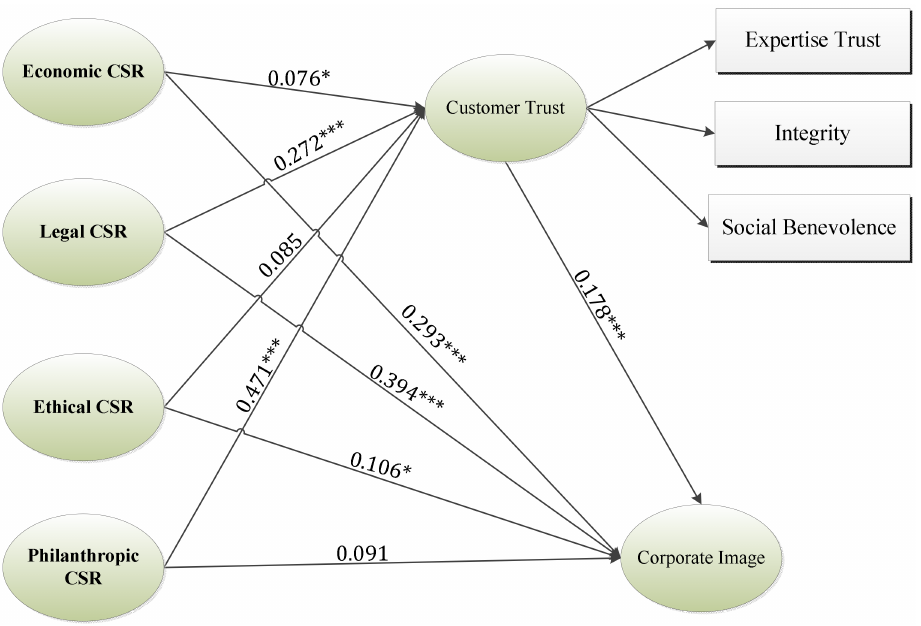
Figure 3. Results of the inner model B. Note: *** p -value < 0.001, * p -value < 0.05.